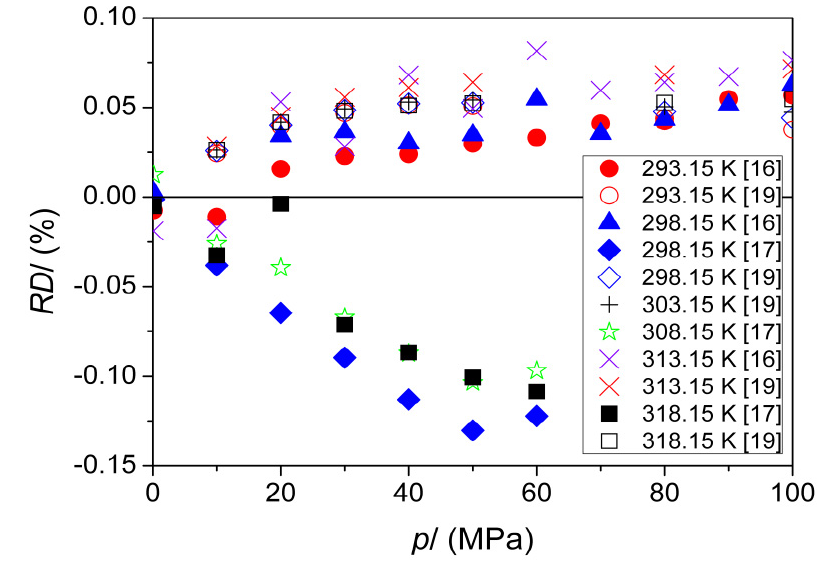
Figure 4. Comparison of the density of 1-butanol as a function of pressure obtained in this work ( ρ this work ) with the literature values ( ρ lit ) [16,17,19] presented as relative deviations RD s ( RD /% = 100 · ( ρ this work − ρ lit ) / ρ this work ).